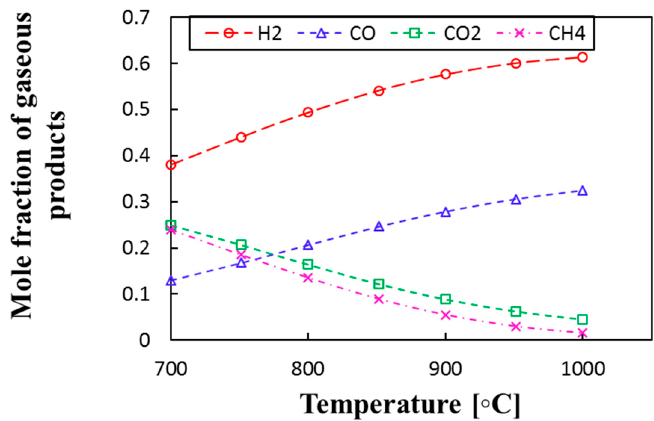
Figure 9. Variation of the mole fraction of the product with temperature at the reference condition for reactor R 2 .